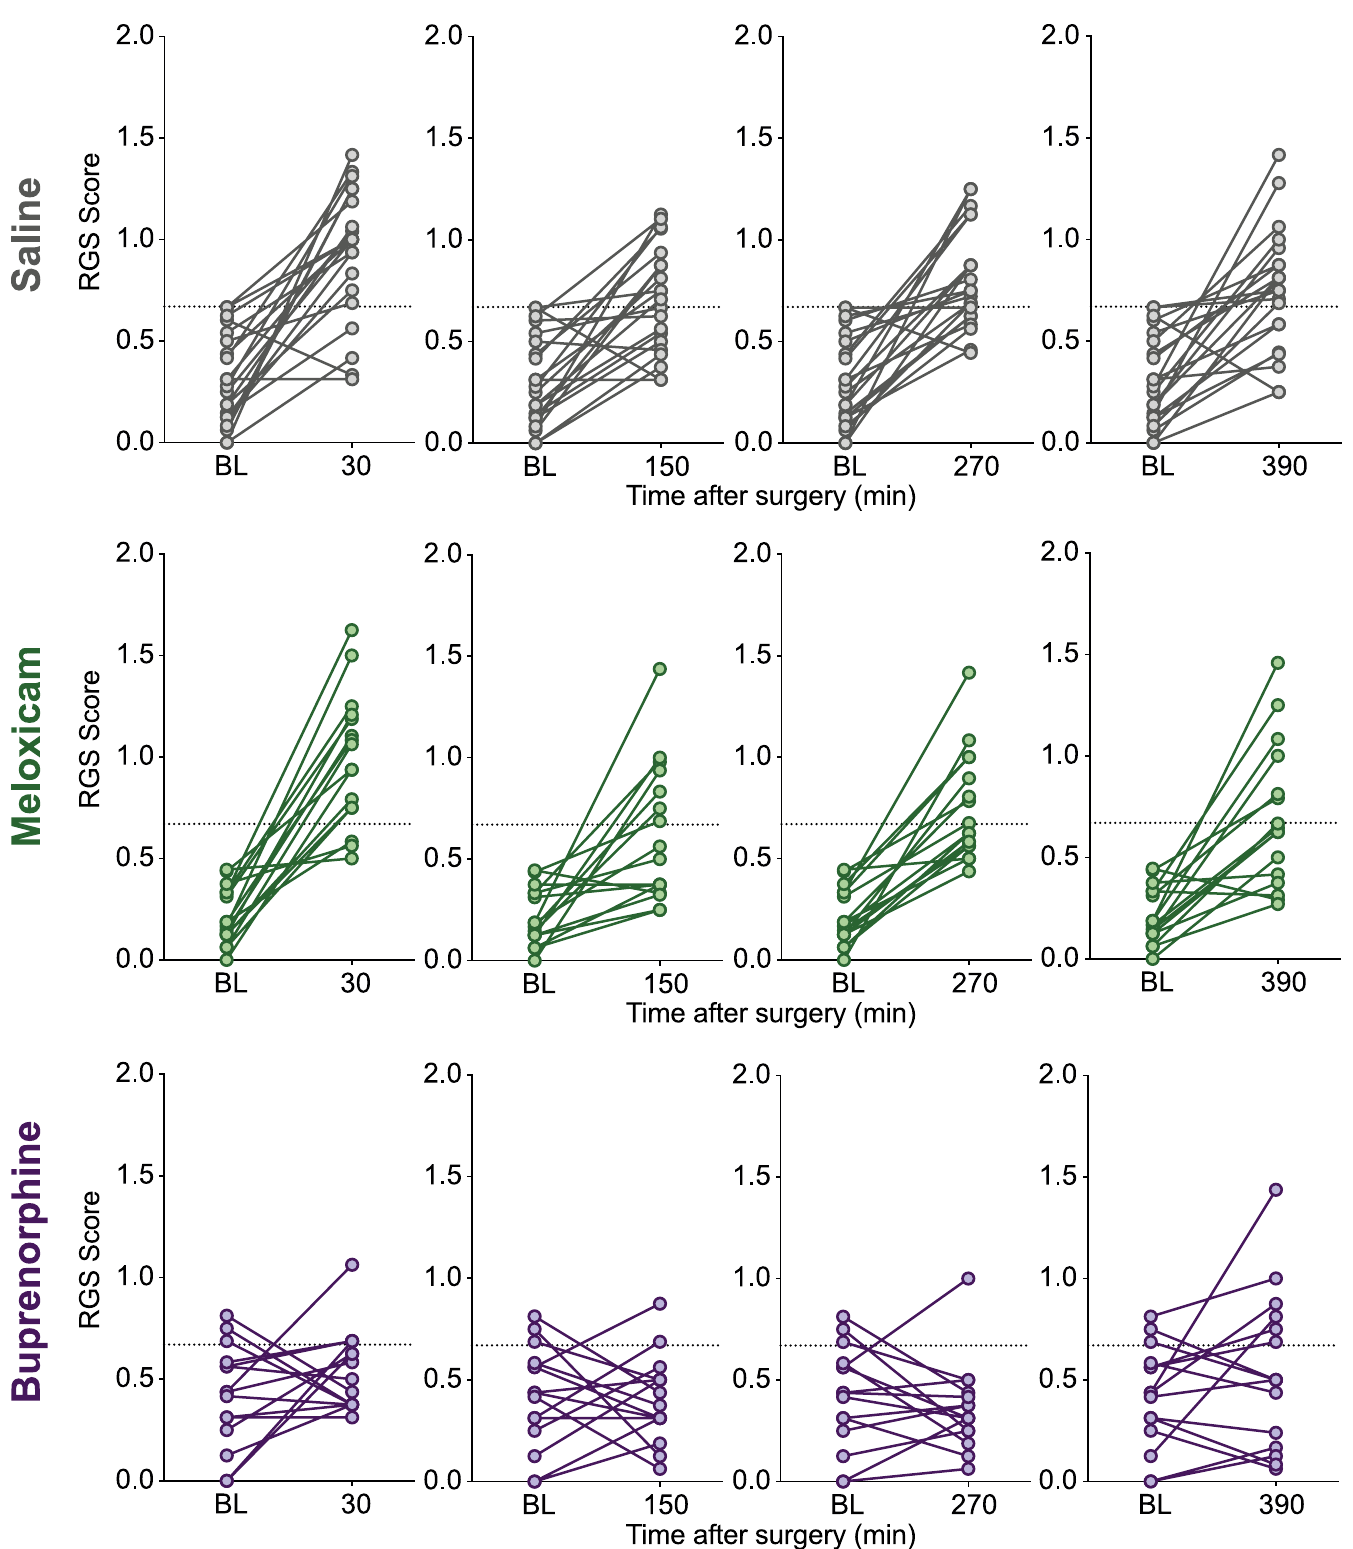
Fig 3. RGS scores of individual rats at all post-surgical timepoints in comparison to their baseline scores. Saline (n = 21), meloxicam (n = 16) and buprenorphine (n = 15) rats at all time points. Horizontal broken line at y = 0.67 indicates analgesic intervention threshold [11].